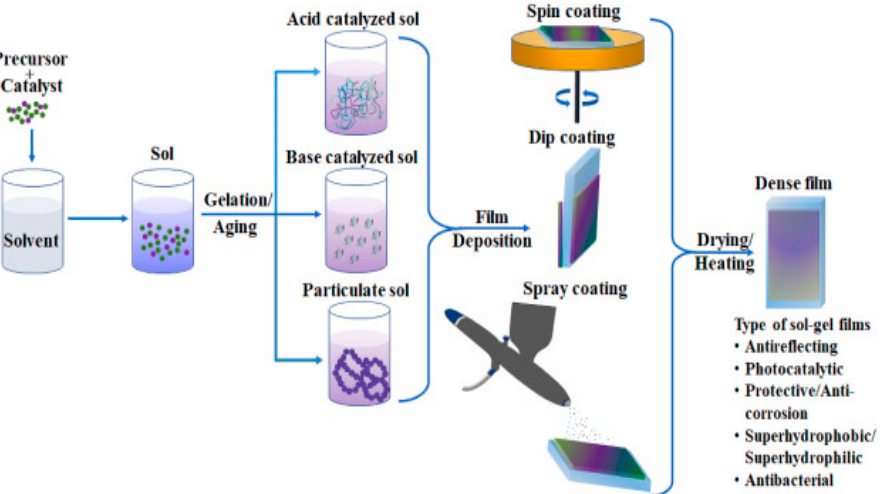
Figure 6. Schematic of some of the important sol ‐ gel processes leading to various type of films/coatings [41].